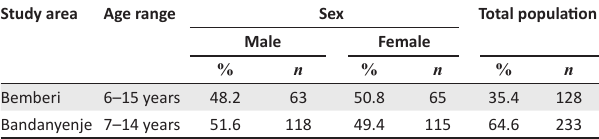
FIGURE 3: Amplicons for tumour necrosis factor-alpha -308 G/A single nucleotide polymorphism. Lane M shows 100 base pair (bp) molecular marker. The 426 bp fragments correspond to the internal control. The 267 bp fragments were specific for G and A alleles of tumour necrosis factor-alpha -308 G/A single nucleotide polymorphisms. Lane 5 shows heterozygous GA genotype. Lanes labelled 6 and 7 show homozygous GG genotype. TABLE 2: Summary of study